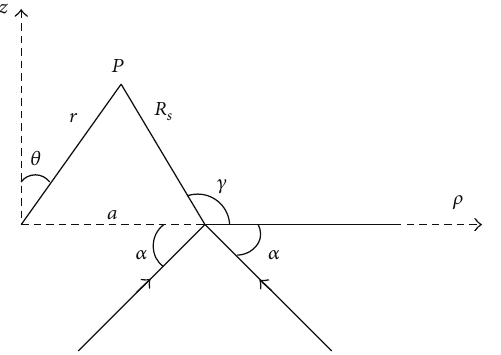
Figure 2: Related angle geometry for the ray components.